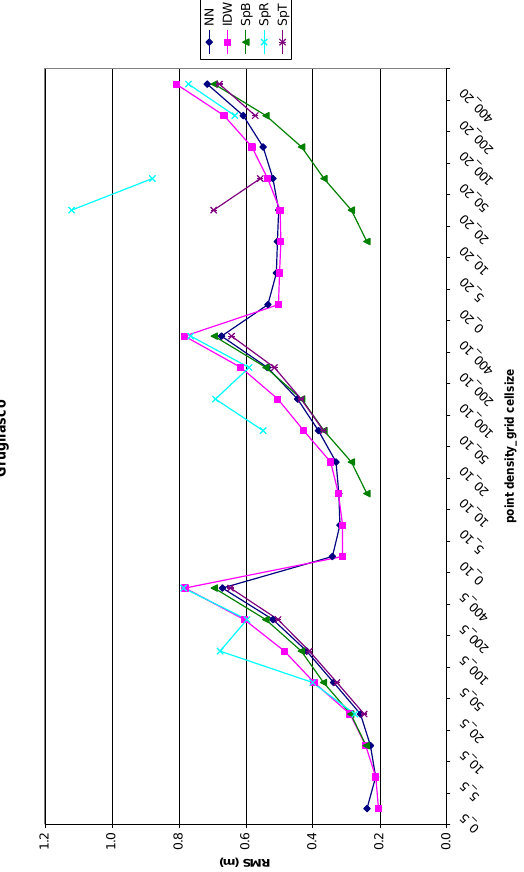
Figure 3. Grugliasco site, quality assessment (NN = Natural Neighbors, IDW = Inverse Distance Weighing, SpB = Tension Spline with Barriers, SpR = Regularized Spline, SpT = Tension